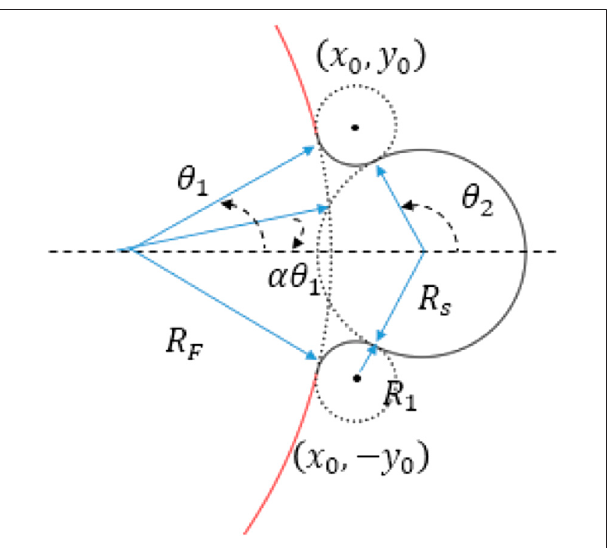
FIGURE 4 | Parameters for the deformed